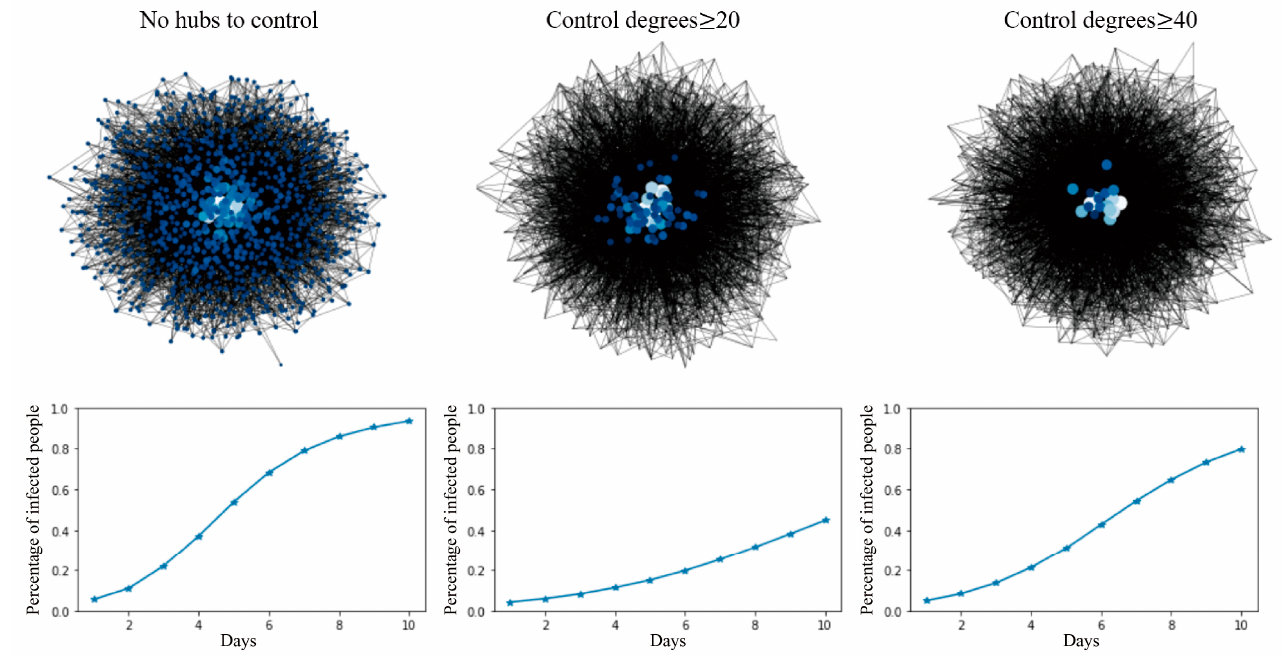
Figure 8. Impact of controlling key nodes (structure holes) on the number of policy recipients.